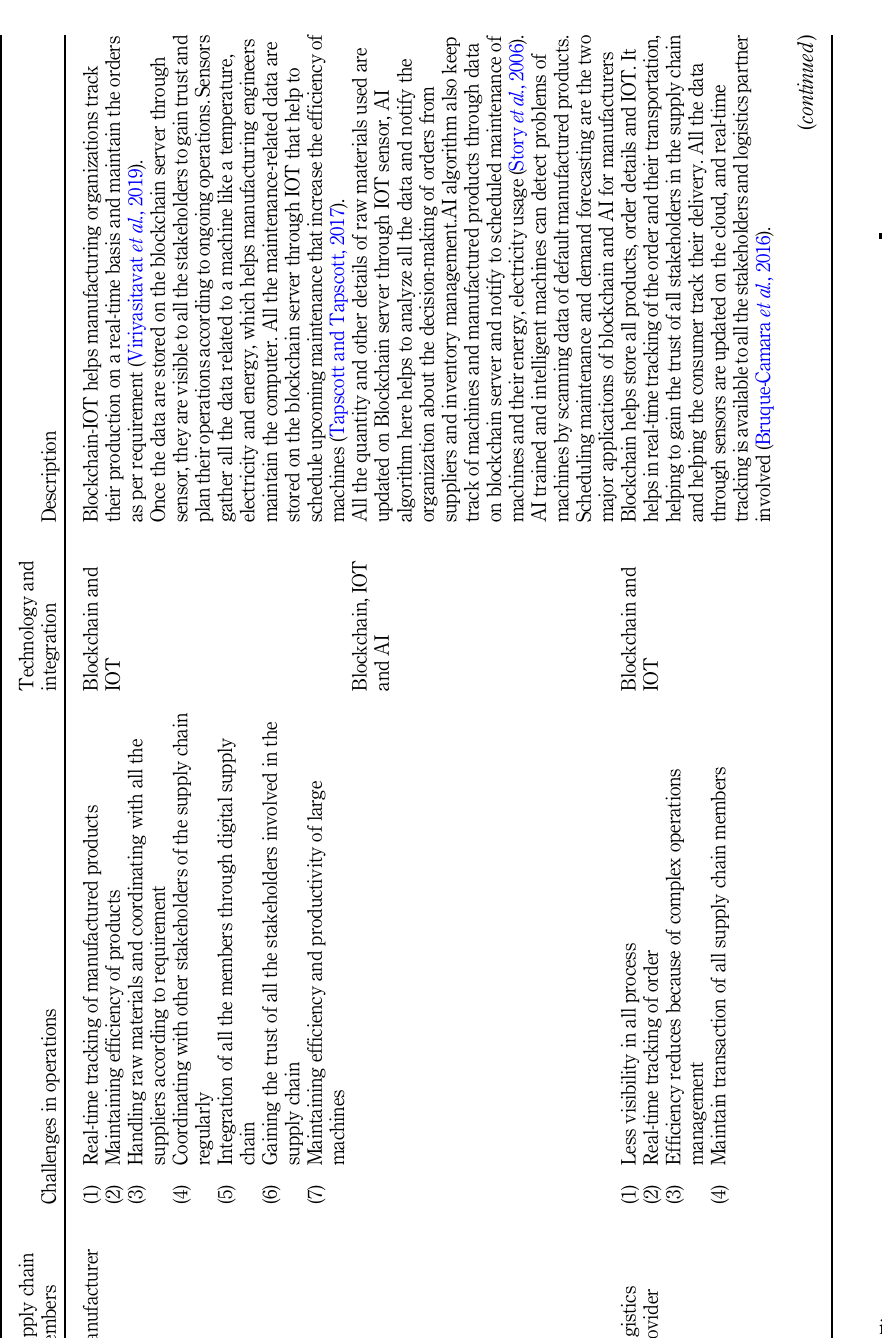
challenges and solutions using blockchain and